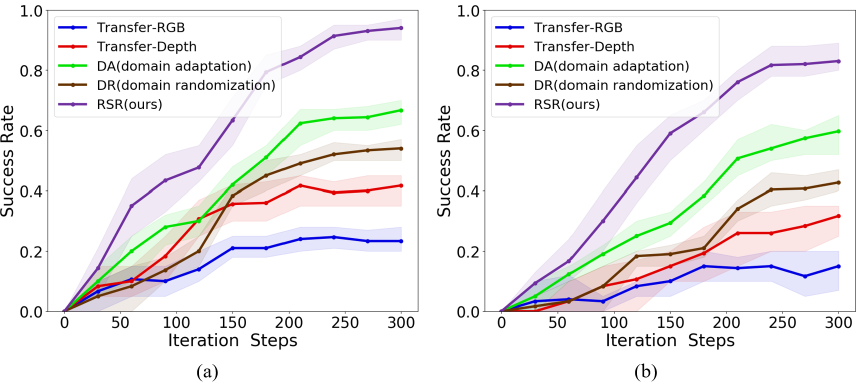
Figure 7. Learning curves for the performance of the policies trained with different methods. ( a ) Manipulation task. ( b ) Navigation task. Compared to the baseline methods, our proposed method shows a better performance. Table 2. Average success rates of the final trained policies employed in real-world